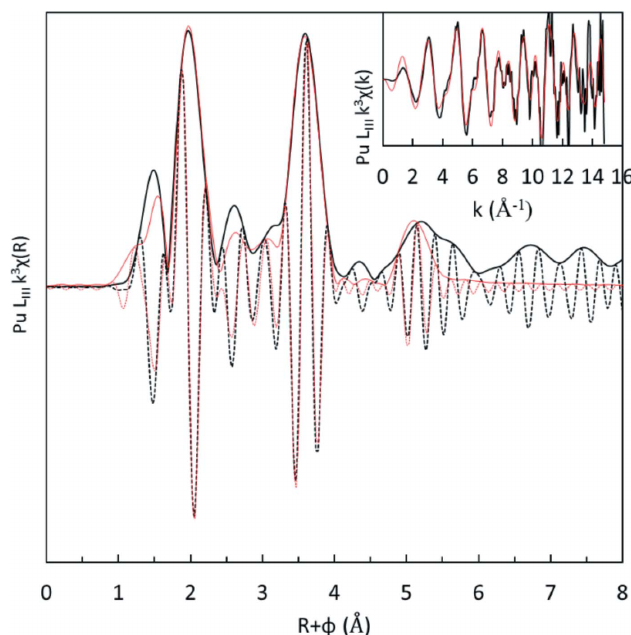
Figure 5 FT of the k 3 -weighted EXAFS spectra (black lines) and best fit results (red lines) of the plutonium solutions prepared by dissolution of Pu IV hexanuclear cluster crystals. The k 3 -weighted EXAFS oscillations and fits are presented in the inset. The imaginary parts of the FTare the black and red dashed